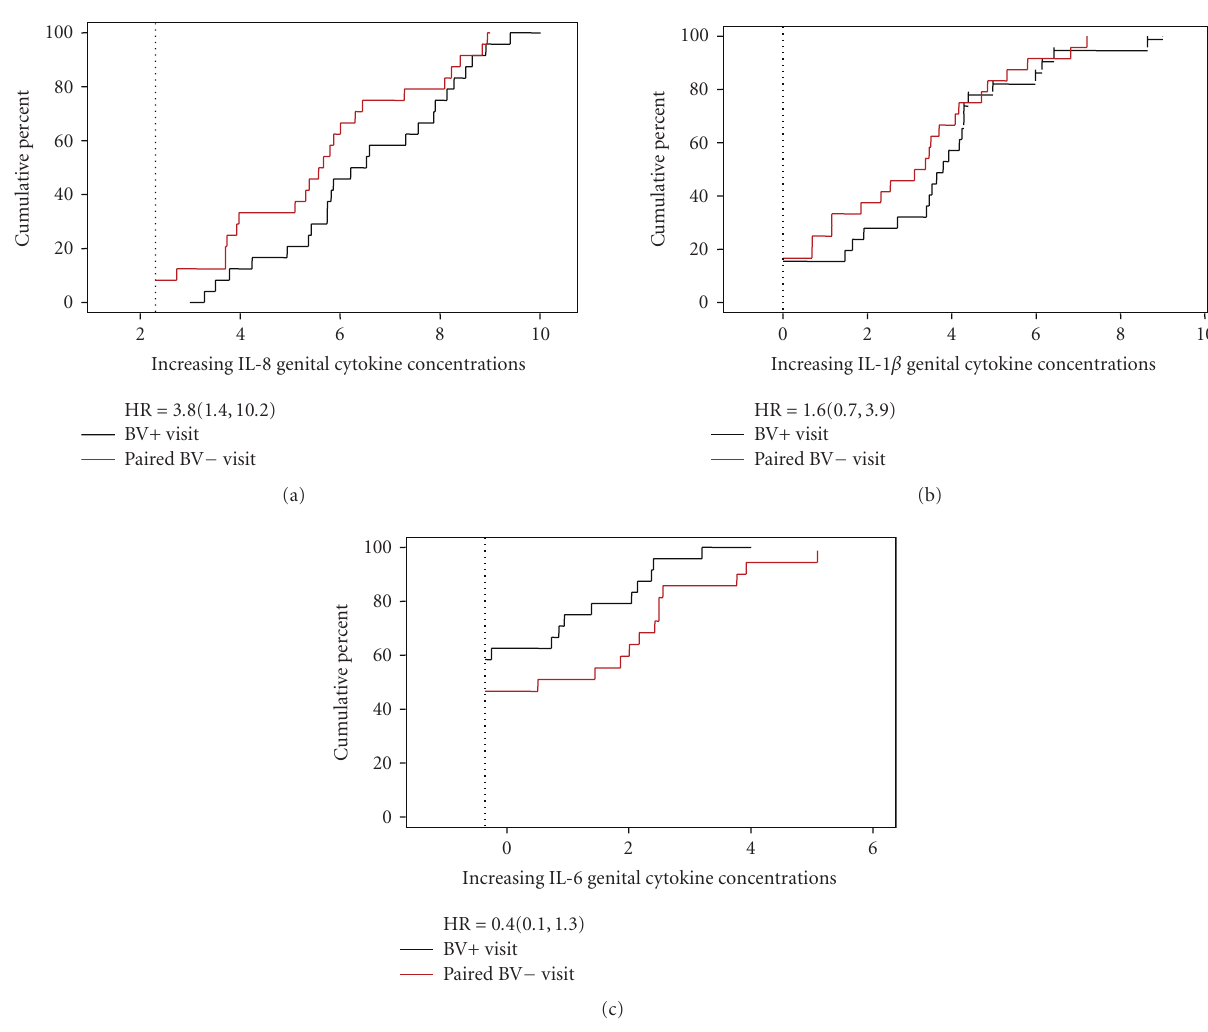
Figure 1: Plots of the estimated cumulative distribution function (CDF) curves for each cytokine by BV status, BV positive (BV+) or BV negative (BV − ), in pg/ml (log 10 ), as well as the hazard ratios and corresponding 95% confidence intervals estimated using a stratified Cox proportional hazard model. IL-8 concentrations when women were BV+ (red line) were significantly higher compared to IL-8 concentra- tions (black line) after the women cleared BV (Hazard ratio = 3.8, 95% CI 1.419, 10.177). The di ff erences in genital tract IL1- β and IL-6 concentrations when women were BV+ versus BV − were not statistically